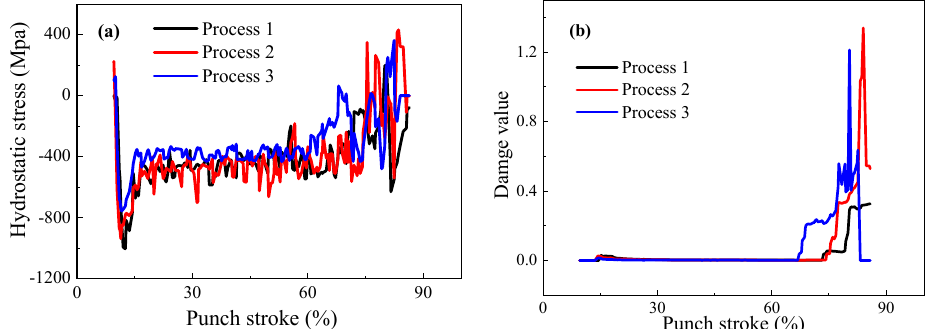
Figure 14. Hydrostatic stress and damage value data of three groups of simulation: ( a ) hydrostatic stress; ( b ) damage value.